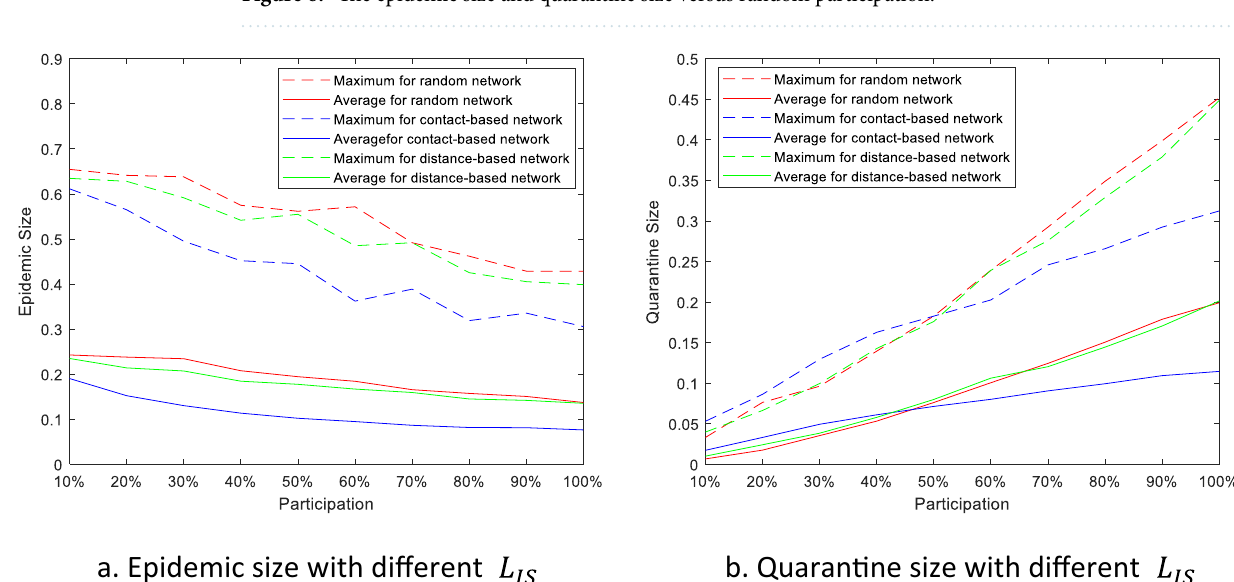
Figure 6. The epidemic size and quarantine size versus random participation.